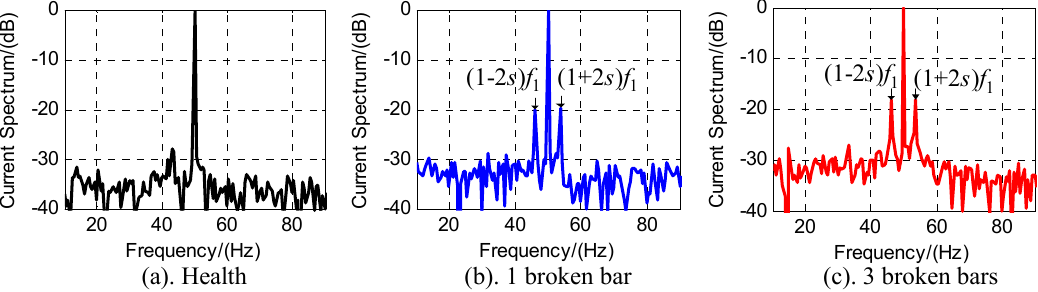
Figure 15. Current spectrums of the healthy and rotor fault motors.